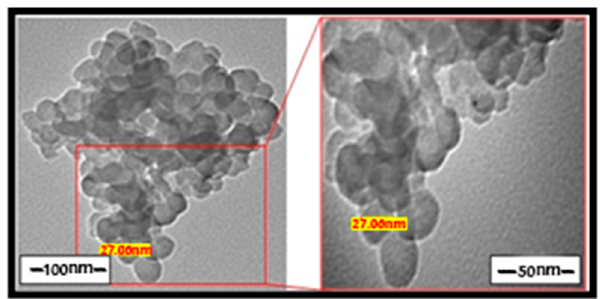
Figure 6. TEM images of some nano chromium complex in the presence of PVA (10 − 5 M).